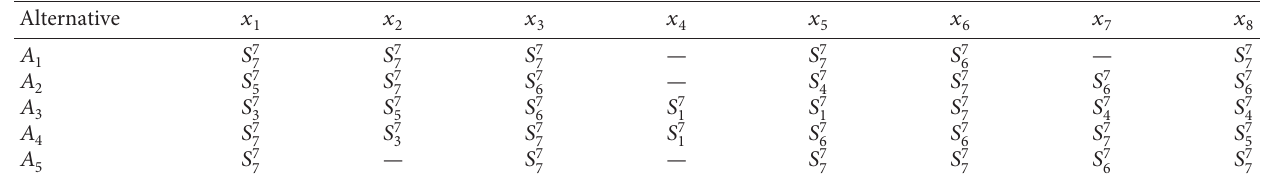
(word-of-mouth data). 7